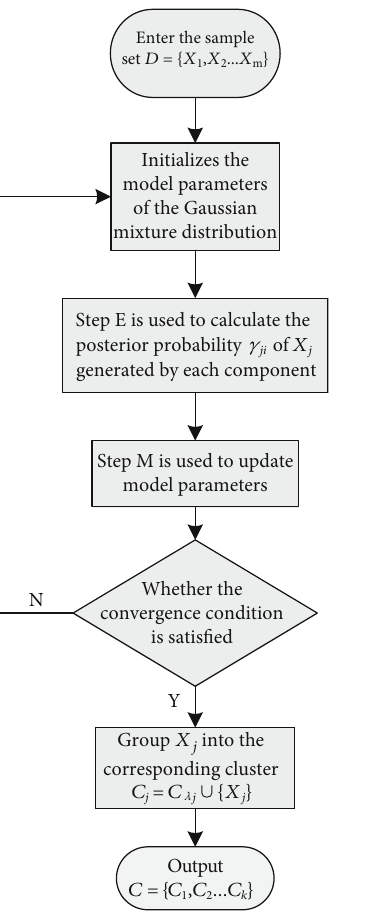
Figure 12: The comparison curves of thermal e ffi ciency under similar